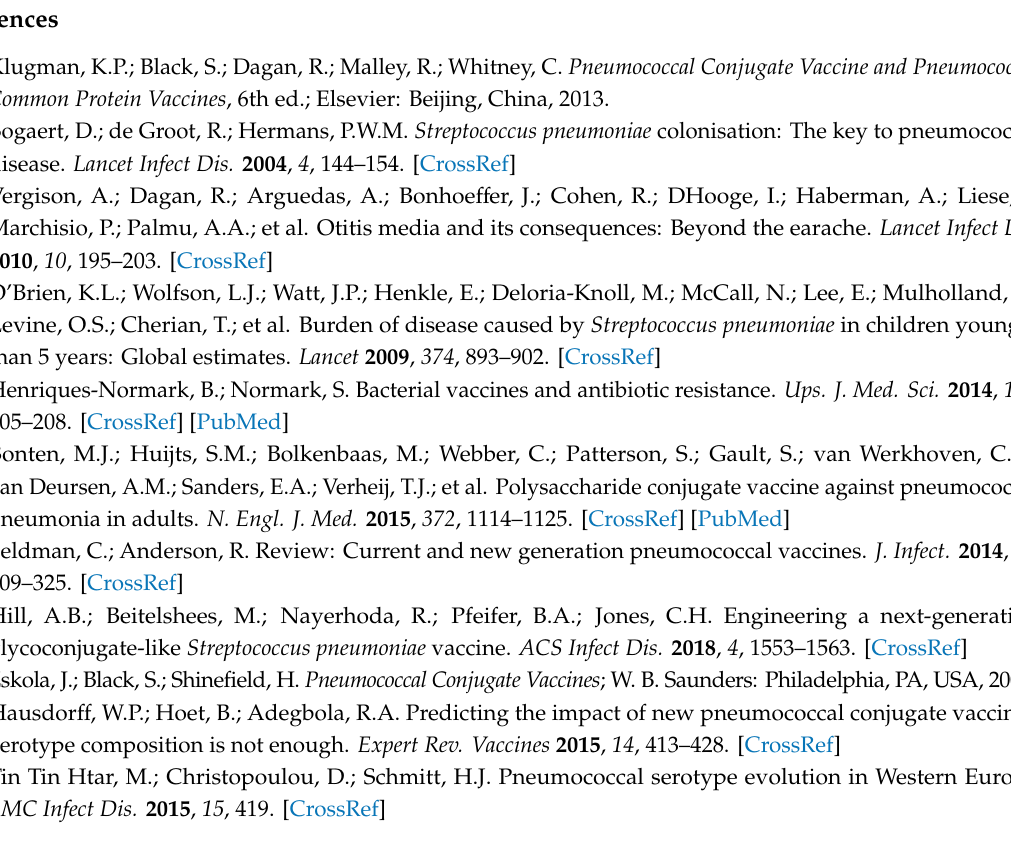
Figure S1: Absorbance spectrum for polysaccharides 4 and